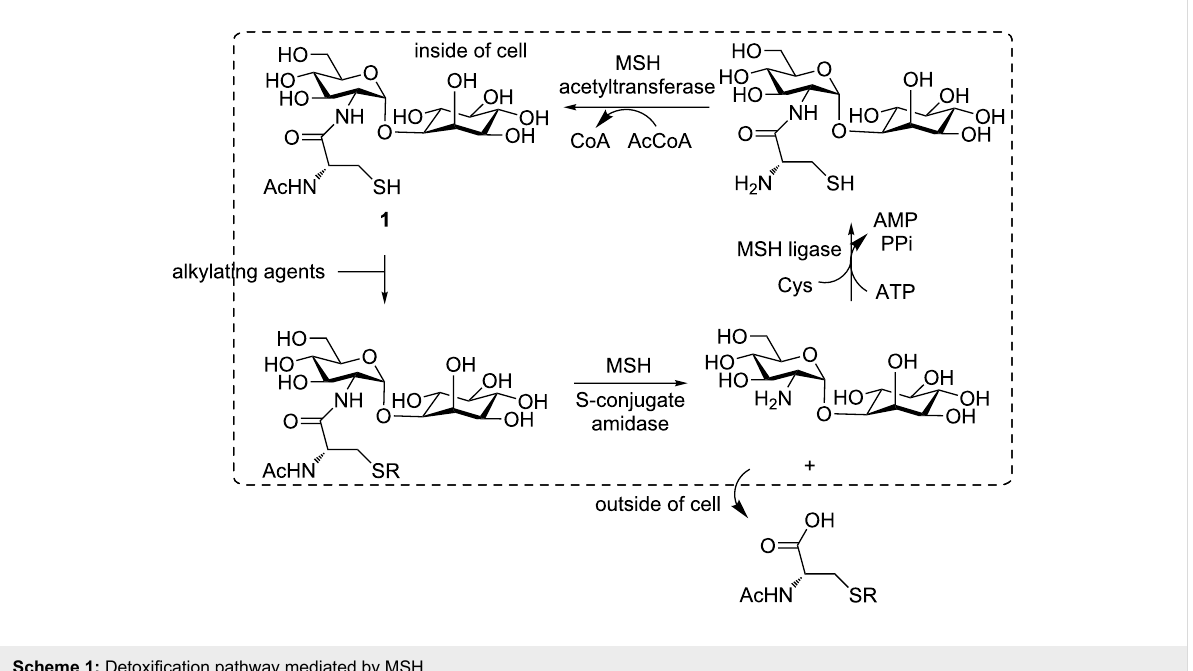
Scheme 1: Detoxification pathway mediated by